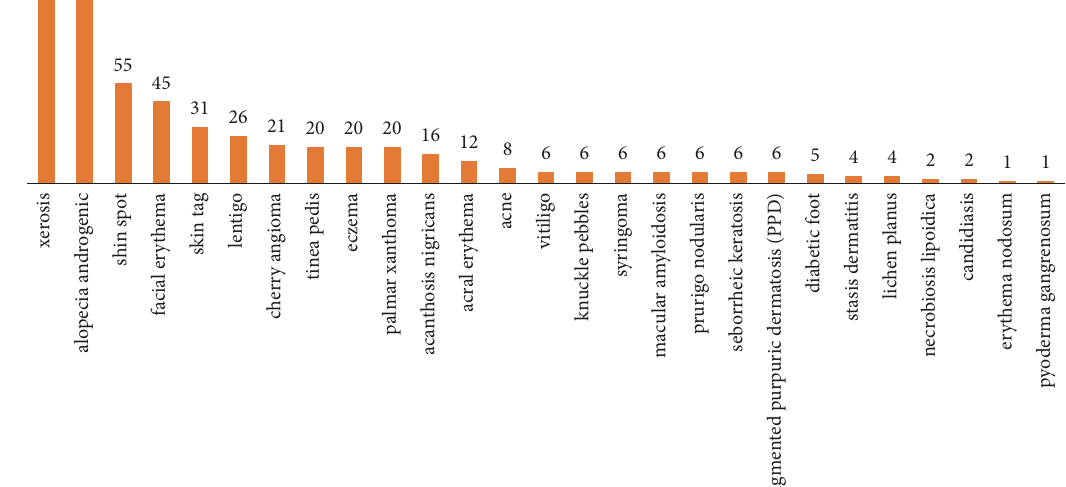
reported prevalence for different types of cutaneous manifes- tations in diabetic patients. Xerosis and Androgenic Alope- cia were two main common cutaneous disorders detected among our patients. Skin tag, facial erythema, shin spot, and lentigo were, respectively, the most prevalent cases